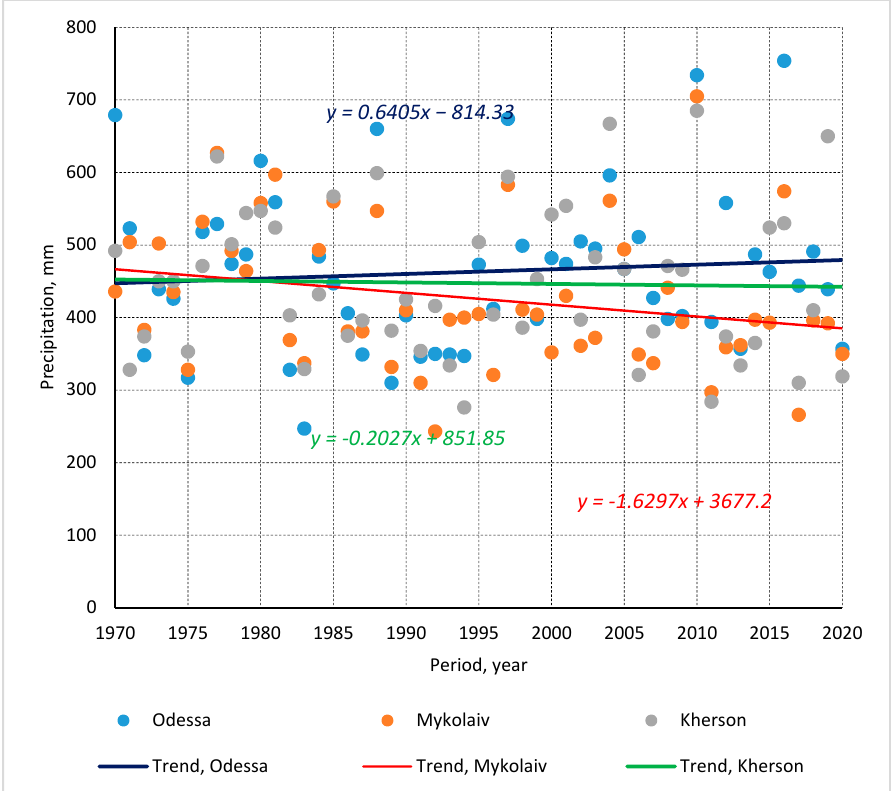
Figure 3. Precipitation for the South of Ukraine (1970–2020).